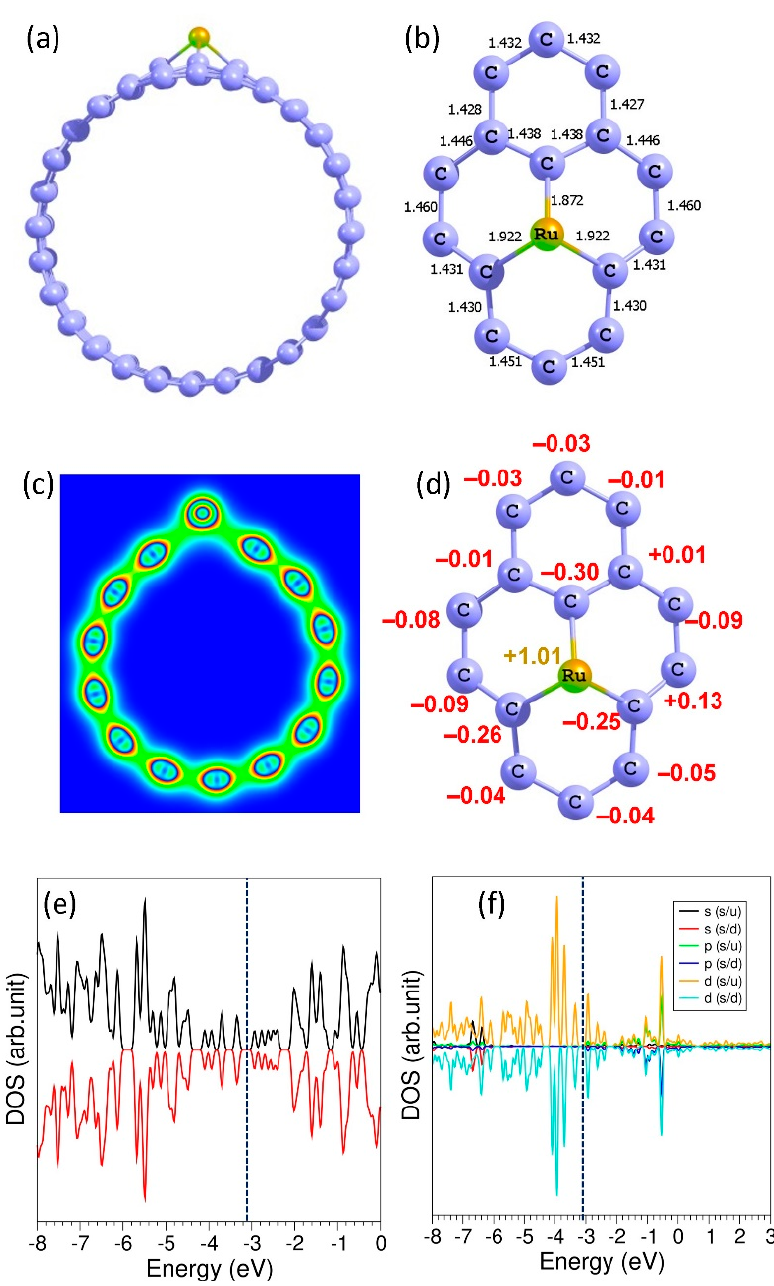
Figure 3. ( a ) Relaxed configuration of the Ru-doped SWNT, ( b ) calculated bond distances measured in Angström around the defect, ( c ) charge density plot showing the interaction between the Ru atom and the nanotube, ( d ) Bader charge on the Ru atom and the nearest neighbor C atoms, and ( e ) total DOS plot and ( f ) the atomic DOS plot calculated for the Ru atom. Vertical dashed lines correspond to the Fermi level.